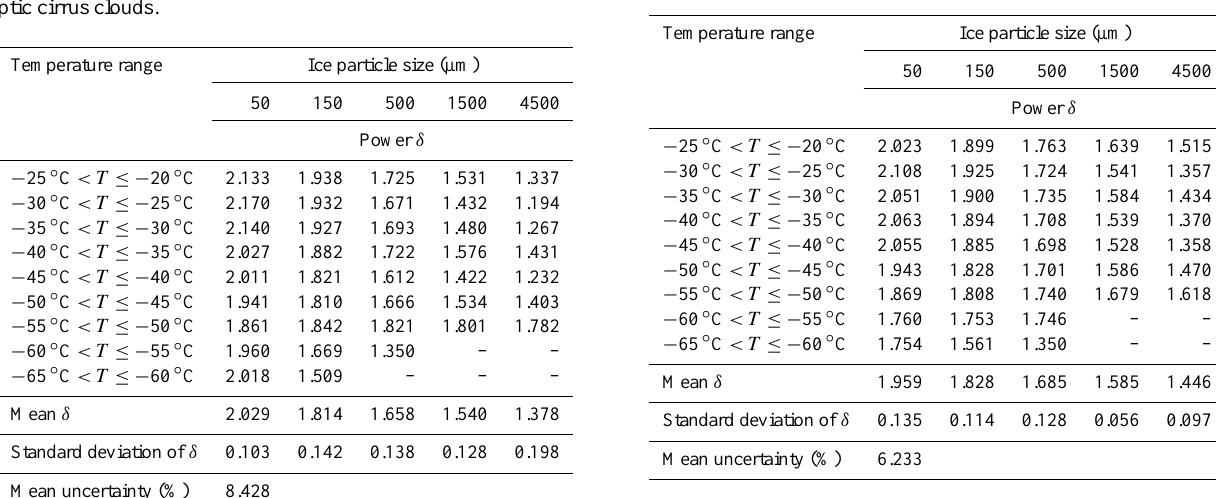
Table 6. Same as Table 5 but for anvil cirrus